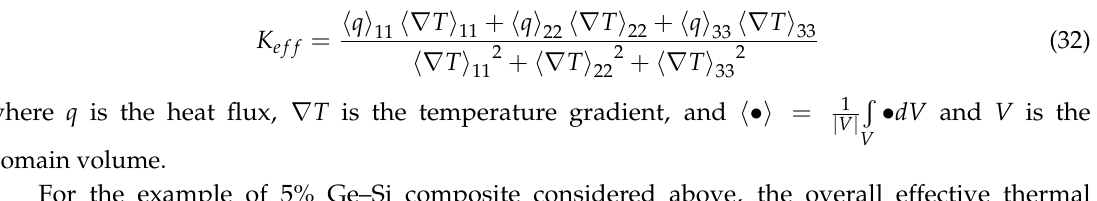
Figure 9. Finite element mesh for computational homogenization.